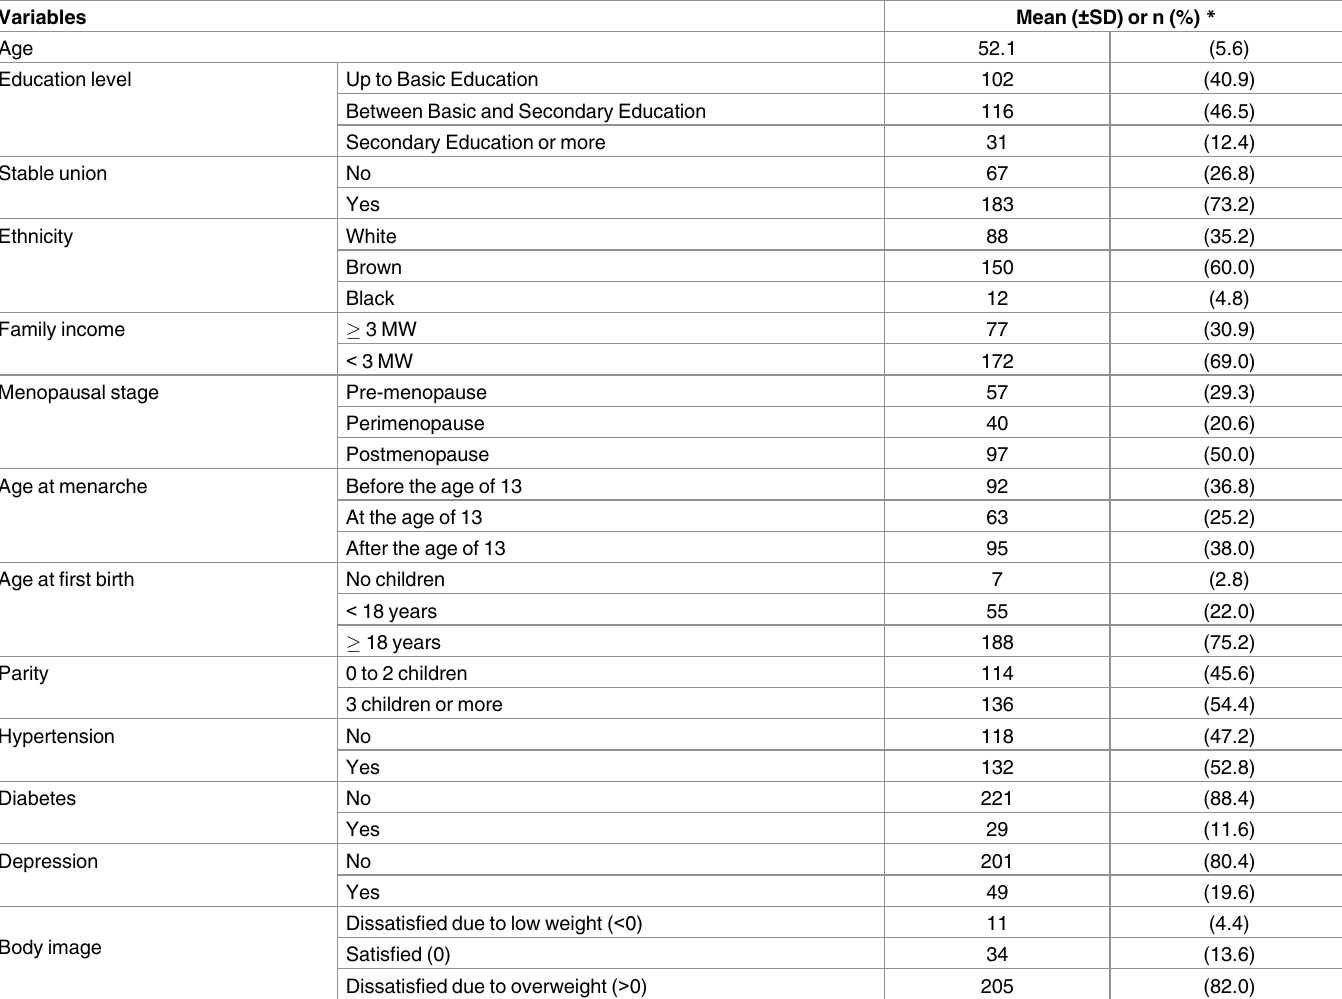
Table 1. Characterization of the